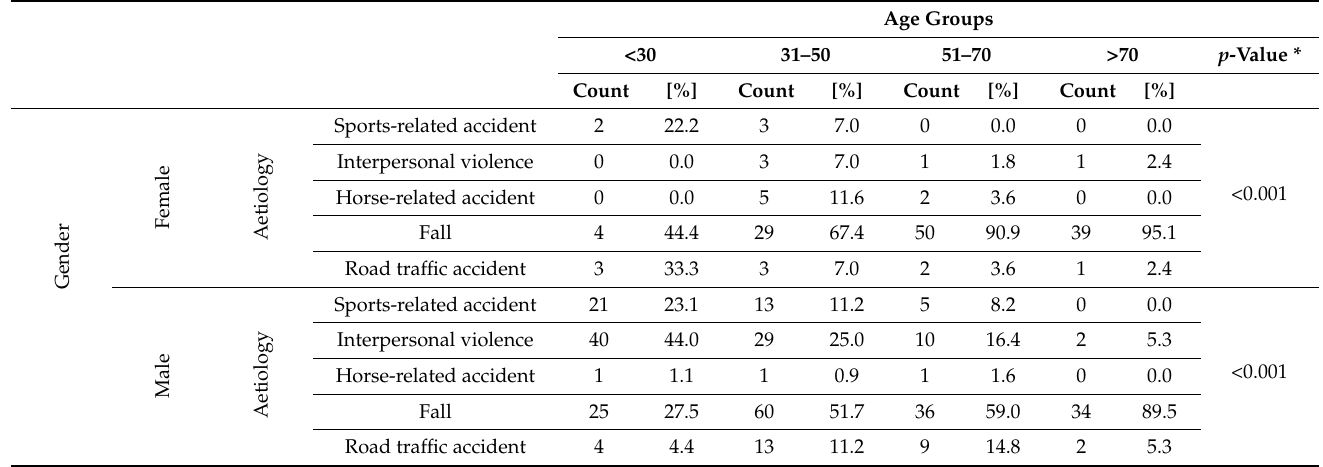
Table 4. Aetiology of 461 retrospectively analysed cases of isolated unilateral zygomatico-orbital fractures according to gender and age groups.